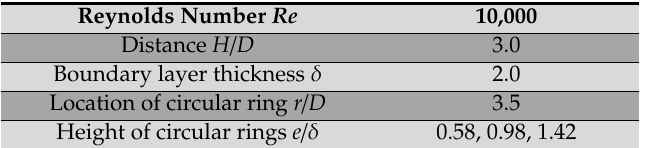
Table 3. Experimental conditions of circular